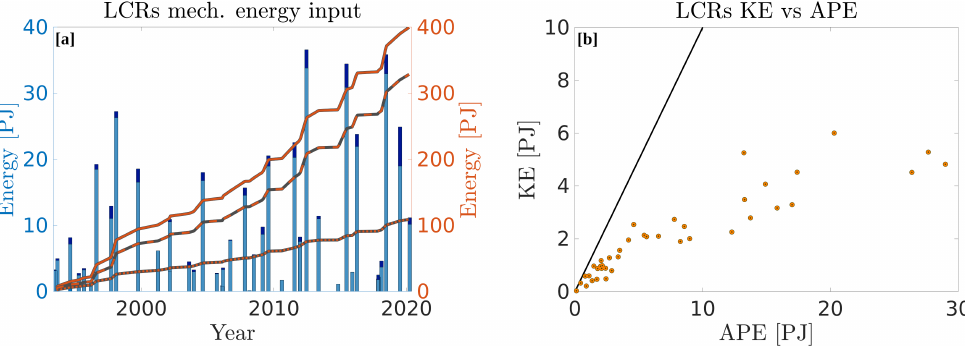
Figure 16. ( a ): Bar graph of the total mechanical energy (sum of the kinetic and available potential energy) of each detached Loop Current rings (LCRs). The light blue bars represent values computed using the maximum velocity contour as the LCR’s edge, while dark blue bars were obtained using the last closed absolute dynamic topography (ADT) contour. The orange curves, referenced on the right-hand side y -axis, represent the cumulative energy input of the LCRs over time. The plain, dotted, and dashed lines represent total mechanical energy (TE), available potential energy (APE), and kinetic energy (KE), respectively. ( b ): KE against APE for each of the 40 detached LCRs. The black line represents equal partition of energy (Burger number equals to